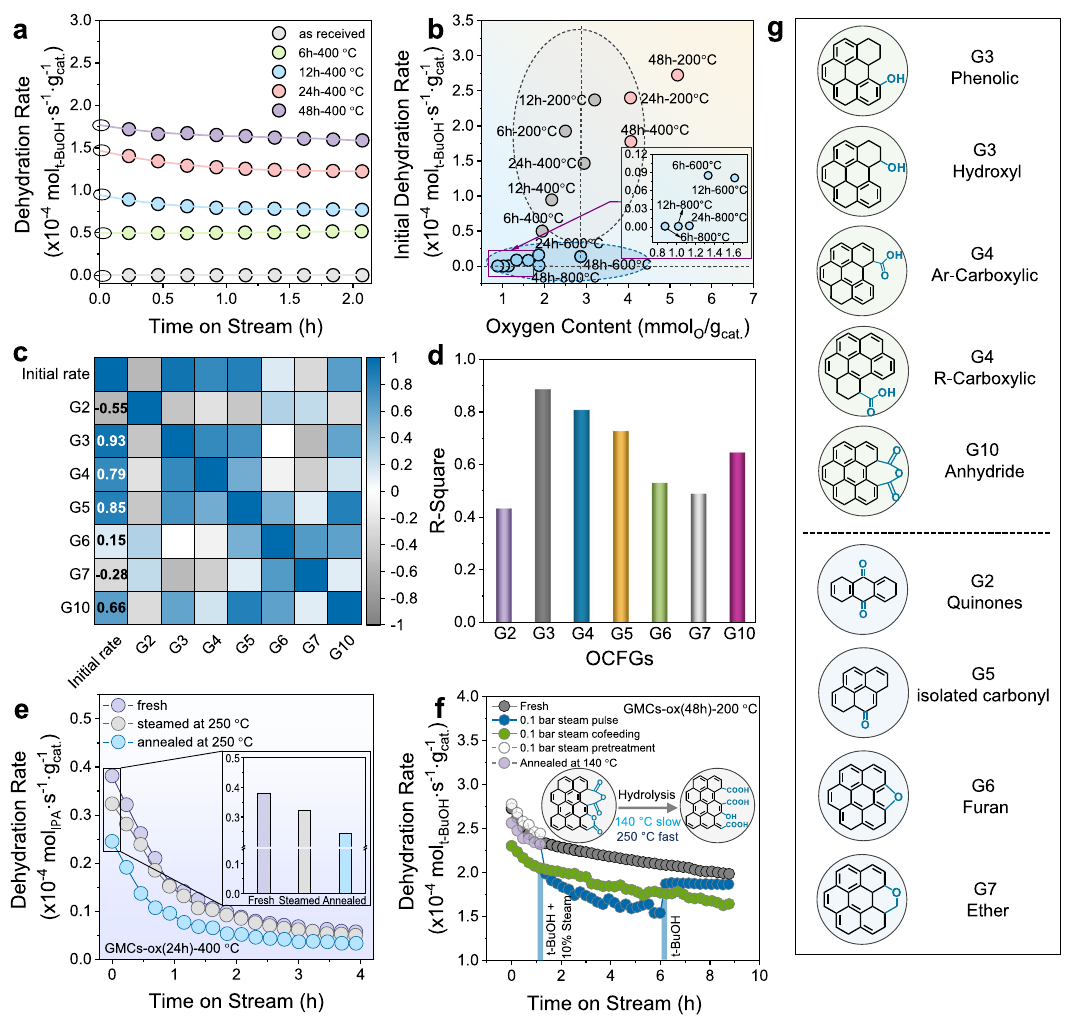
Fig.3| Probereactionandkeyreactivitydescriptors.a tert -butanoldehydration rate on oxidized samples. Reaction conditions: 140°C, 4mol% t-BuOH, 10mg cat- alyst. The initial rates are estimated using a 3 rd -order polynomial fi t and extra- polated to zero reaction time. b Correlation between oxygen content and initial rate. c Correlation matrix, showing the correlation coef fi cientsbetween descriptor pairs.Thepurpleandgraycolorsindicateastrongpositiveandnegativecorrelation between factors. d R square of scatter plot of the initial rate against the con- centrationofOCFGs. e Dynamicsofactivesiteswithpretreatmentconditions(inset